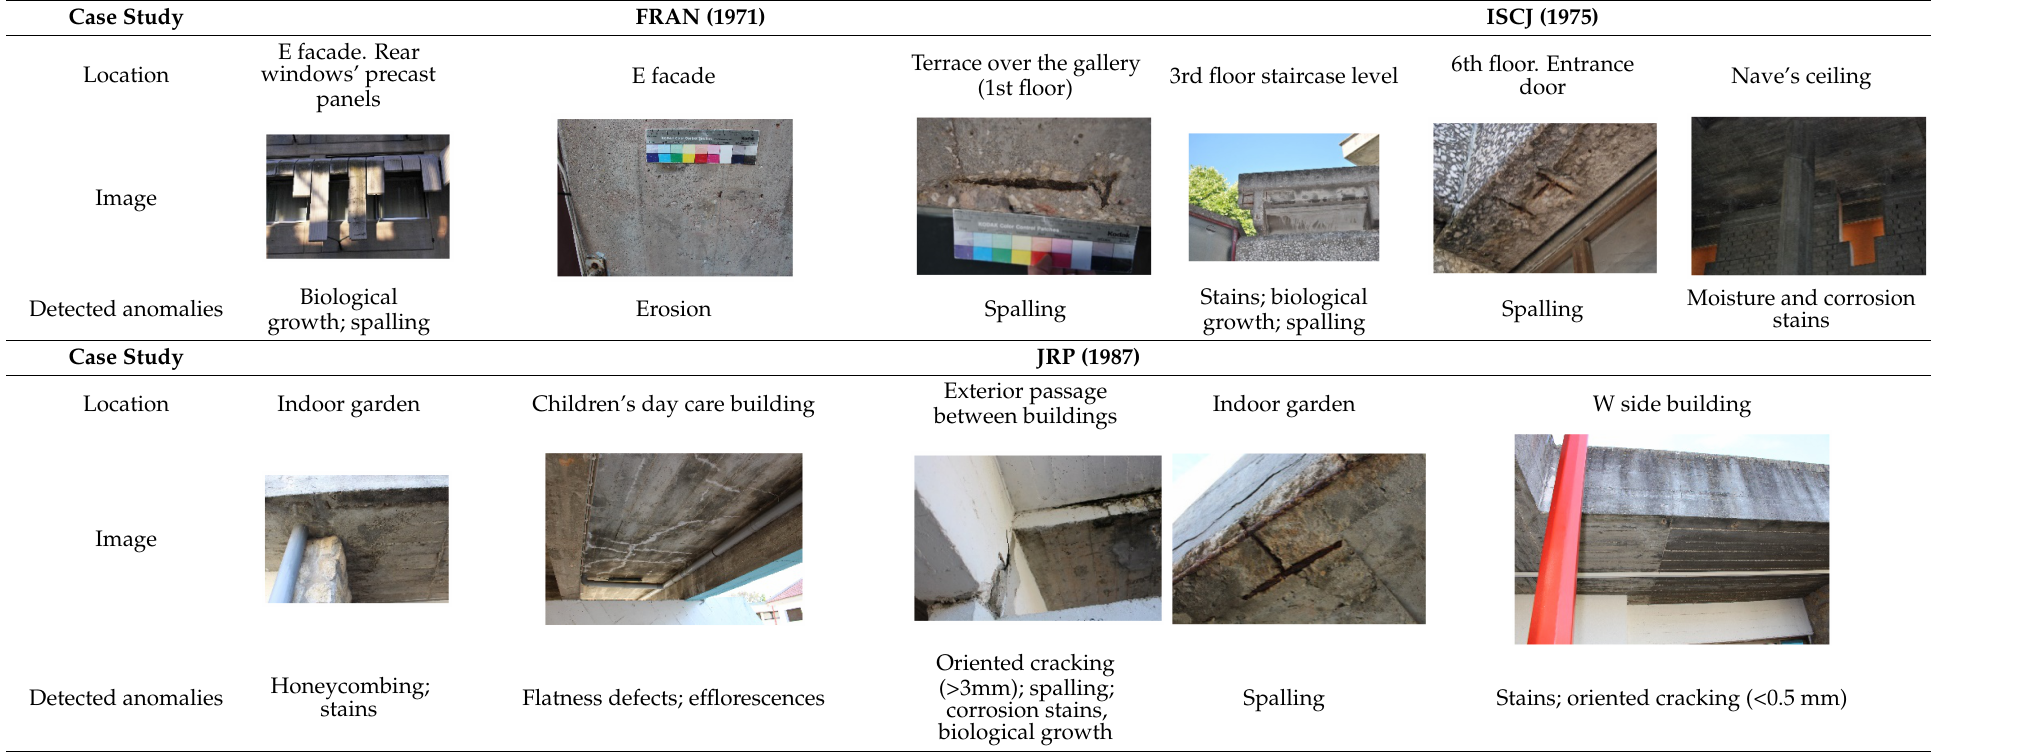
Table 9. Examples of main types of anomalies detected in architectural concrete surfaces of